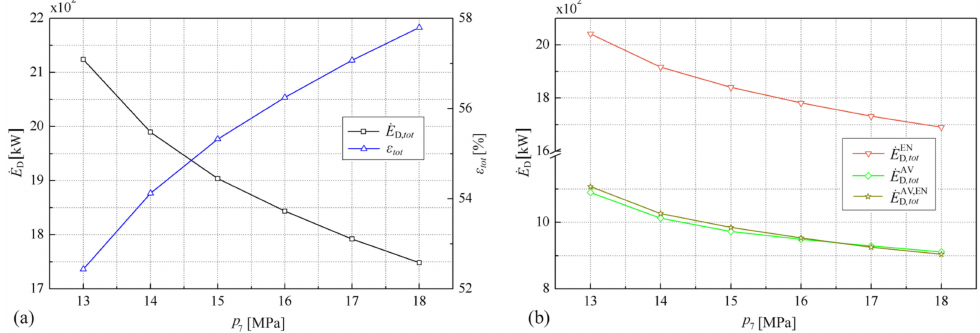
Figure 7. E ff ects of storage pressure: ( a ) conventional exergy analysis results; ( b ) advanced exergy analysis